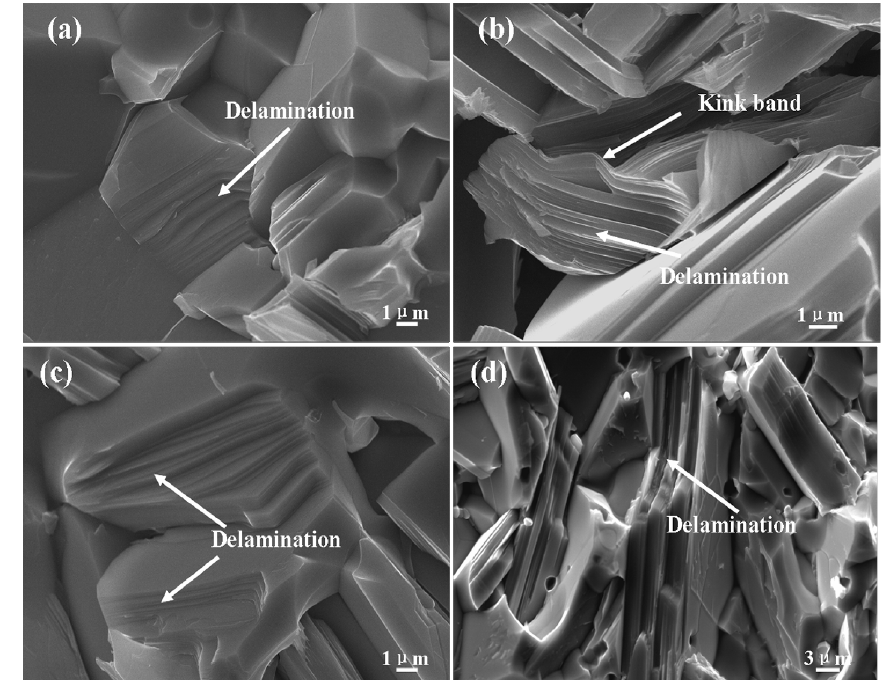
Fig. 5 SEM micrographs of the damaged modes observed in fracture surfaces of (a, b) Ti 2 AlC and (c, d) Ti 2 AlSn 0.2